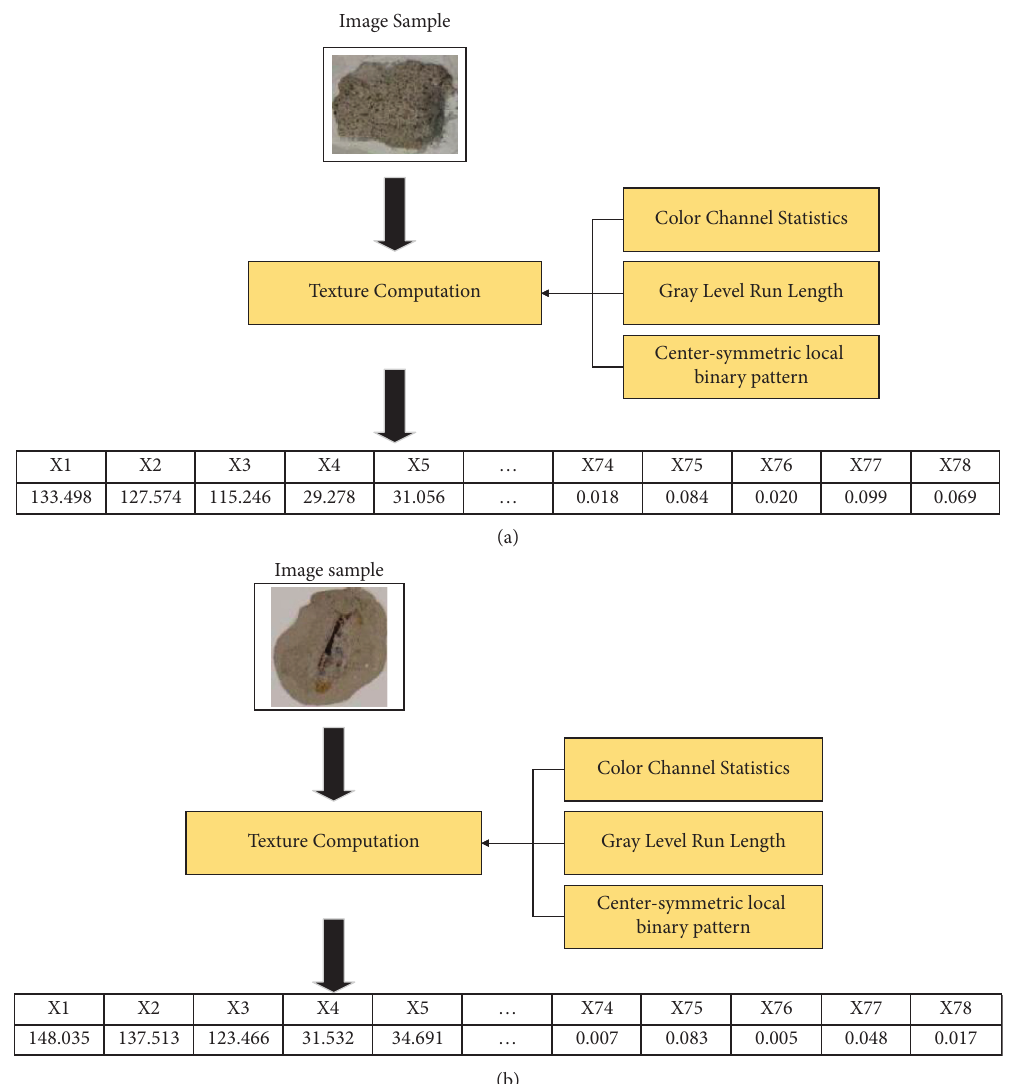
Figure 7: Demonstration of the feature extraction process: (a) a sample of the “shallow spall” class and (b) a sample of the “deep spall”